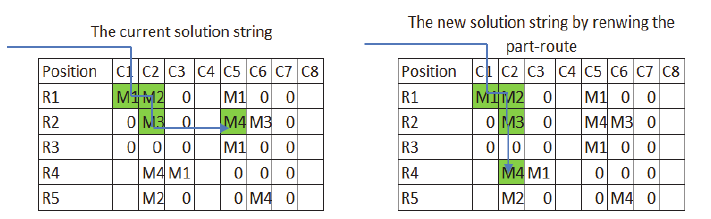
Fig. 3. Generating a new solution string by replacing two related elements in part routing process (left to